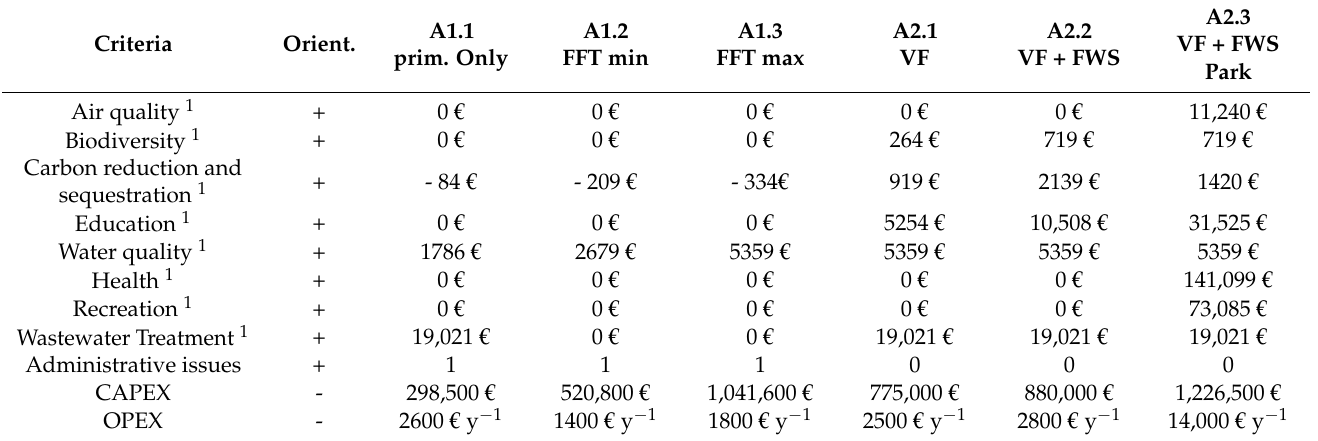
Table 4. Effect matrix of MCA, including results of value transfer for ecosystem services, for all the alternatives.